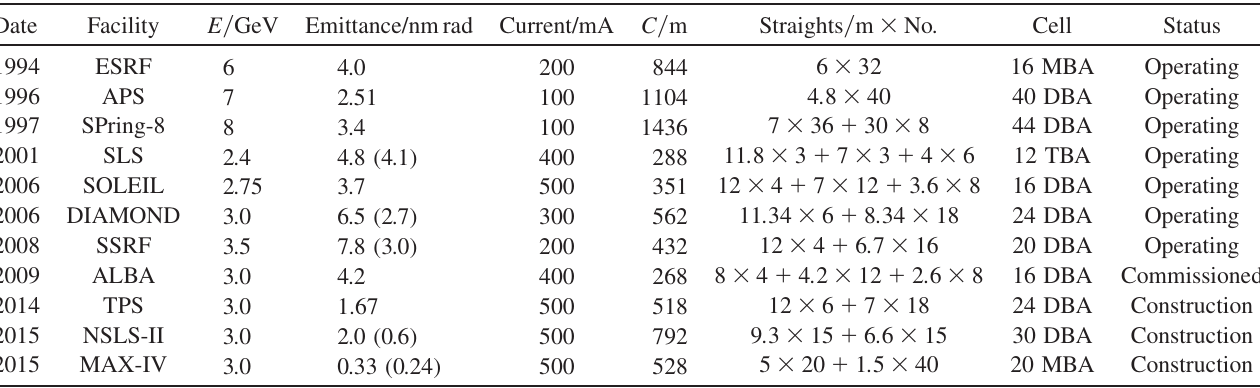
TABLE I. Current status of storage-ring synchrotron-radiation facilities constructed worldwide in the past decade and in the